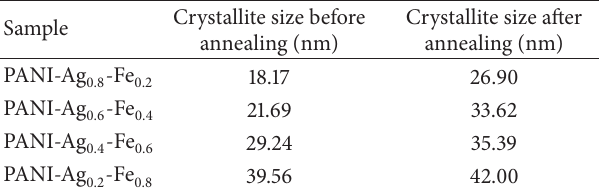
Figure 2: XRD patterns of PANI-Ag-Fe nanocomposite thin films samples (a) before annealing and (b) after annealing.